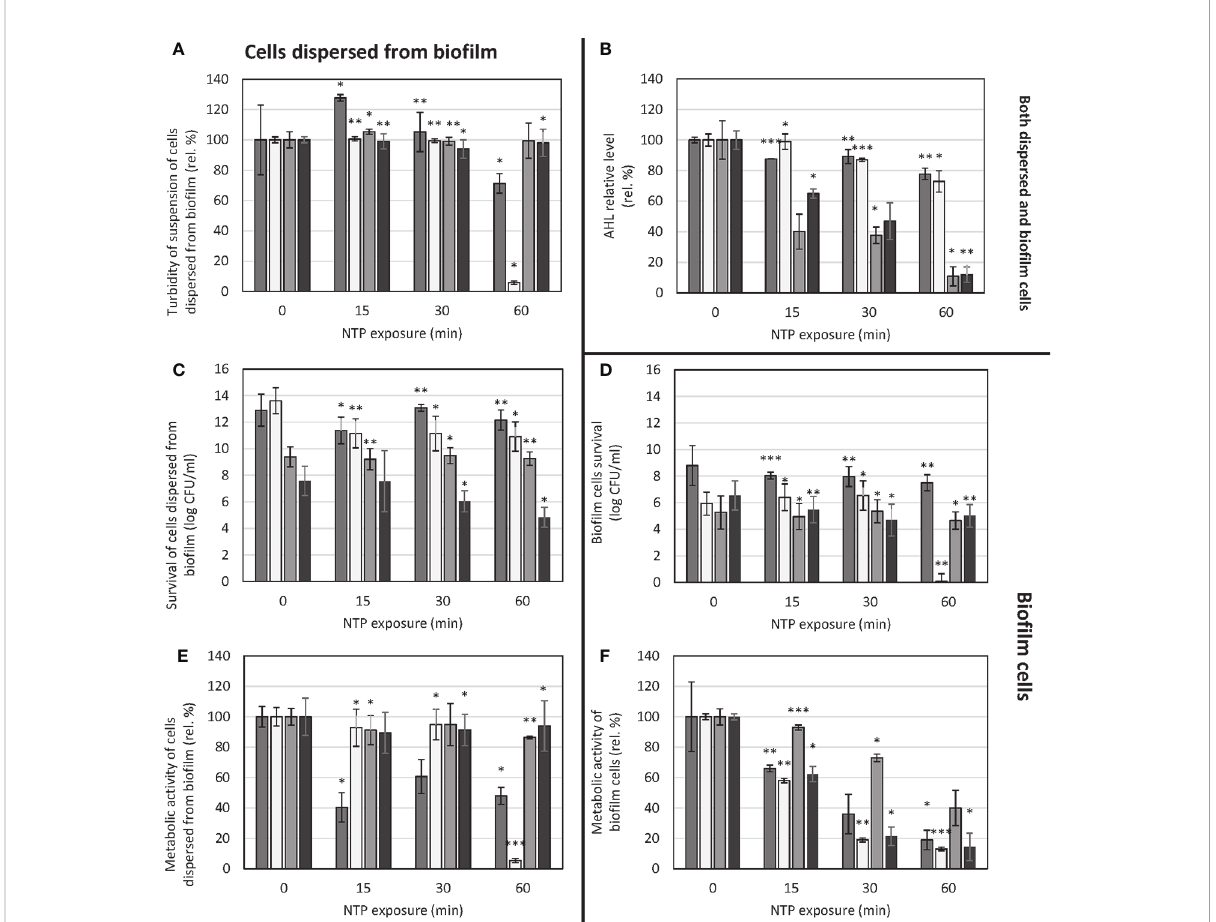
FIGURE 1 Effect of NTP exposure on survival and viability of cells dispersed from bio fi lm as well as bio fi lm cells of Pseudomonas aeruginosa and AHL relative level. (A) – turbidity of suspension of cells dispersed from bio fi lm, (B) – AHL relative level, (C) – survival of suspension of cells dispersed from bio fi lm, (D) – bio fi lm cells survival, (E) – metabolic activity of suspension of cells dispersed from bio fi lm, (F) – metabolic activity of bio fi lm cells. ■ P. aeruginosa ATCC